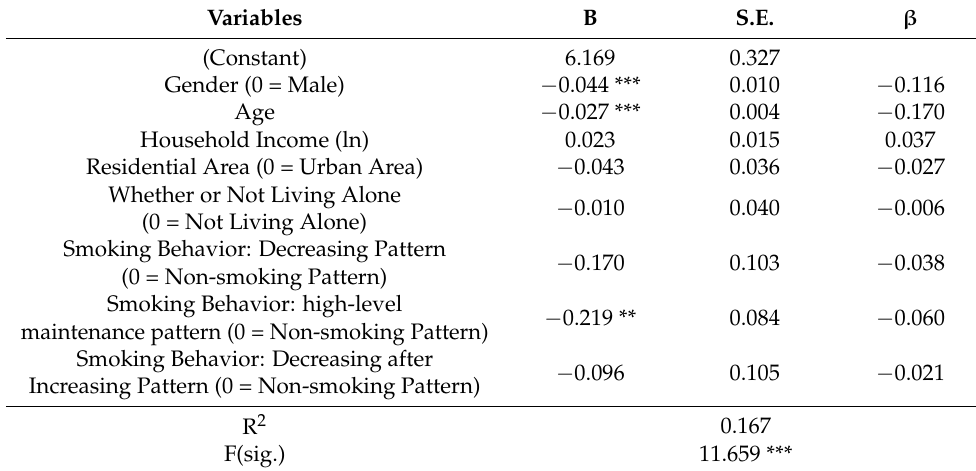
Table 5. Multiple Regression Analysis for Oral Health ( n =